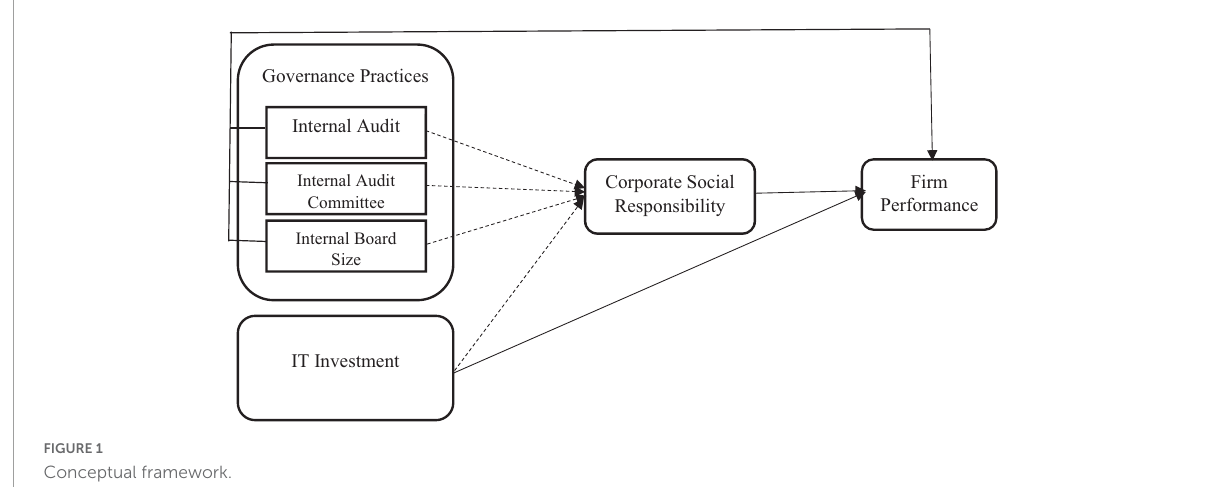
FIGURE1 Conceptual framework.